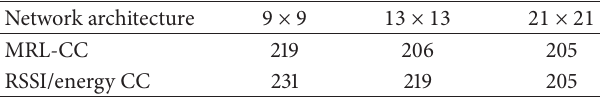
Table 5: Network lifetime (in days) till the WSN can not transmit to the sink